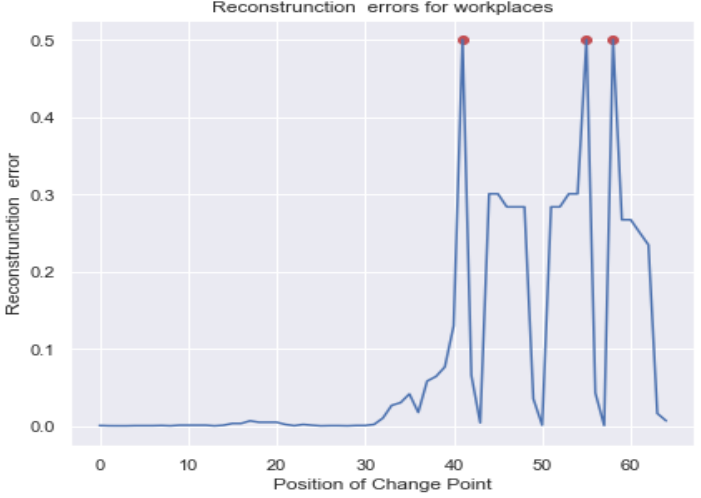
Figure 6. Reconstruction errors for workplaces.